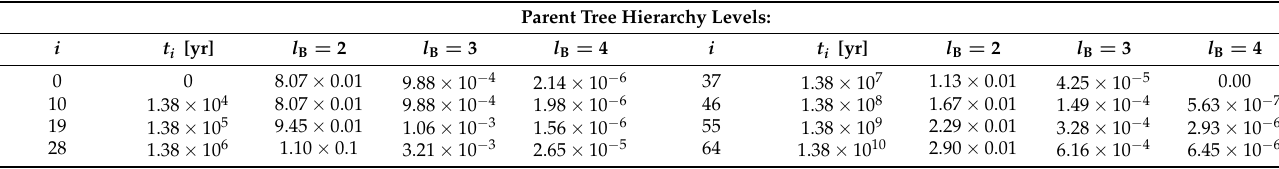
Table 9. Fraction of binaries at each of the eight time-slices dividing the seven runs. Each level l B indicates the level in the binary hierarchy, with l B = 2 indicating two bound PBHs in a binary system, l B = 3 indicating a binary system within another binary system and l B = 4 indicating a binary system within another two binary systems. Note that there are N r = 7 time-runs, for a total of eight bounding time slices, corresponding to the times shown in Table 2. Parent Tree Hierarchy